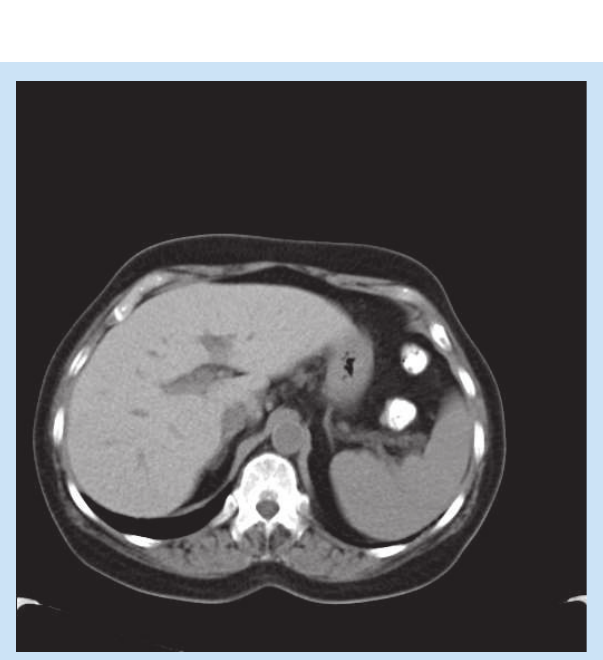
Fig. 1a. Axial T1W images demonstrating decreased signal in the liver and spleen.